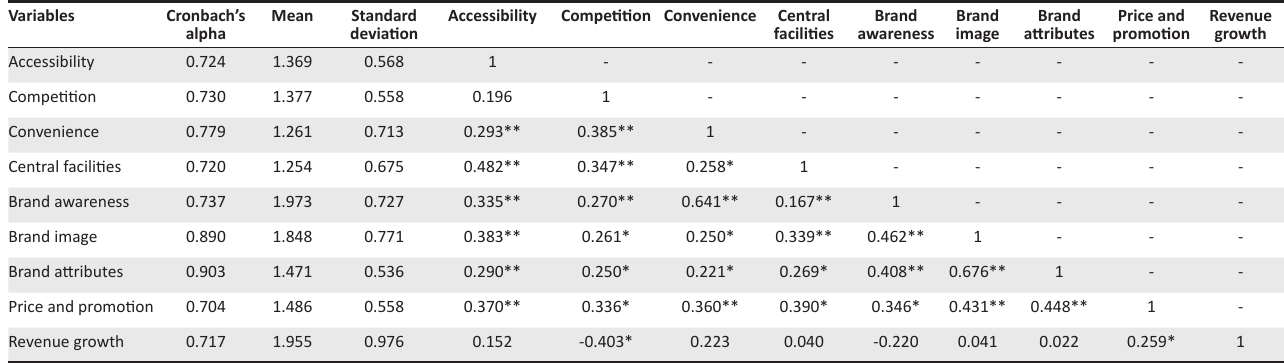
TABLE 1: Reliabilities, descriptives and correlations. Variables